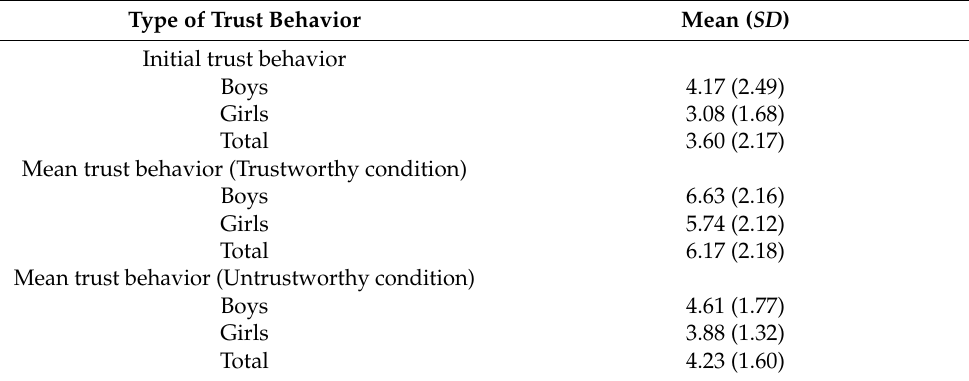
Table 1. Descriptive statistics per type of trust behavior.